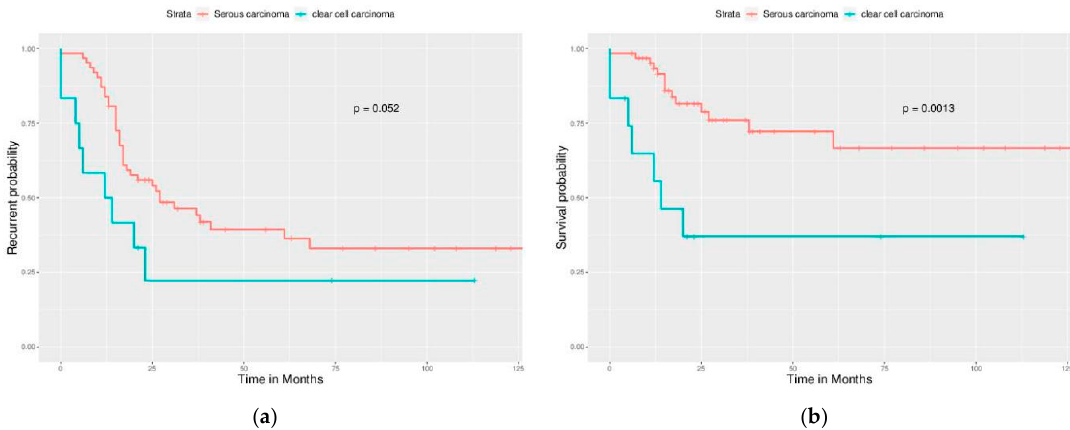
Figure 7. Survival curves by cell type (Optimally debulked group). Focus on serous type and clear cell type. Clearly, clear cell carcinoma still has a worse outcome than serous carcinoma. ( a ) PFS, p = 0.052, ( b ) OS, p = 0.00013.